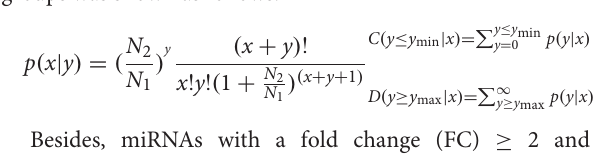
Frontiers in Medicine |